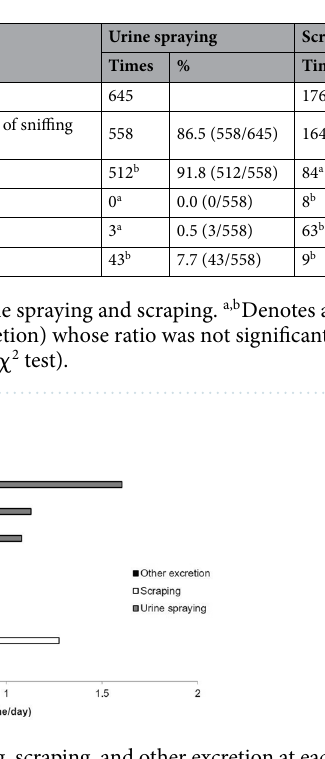
Figure 3. Frequency of urine spraying, scraping, and other excretion at each target location. The daily observation time was 25 min after release.